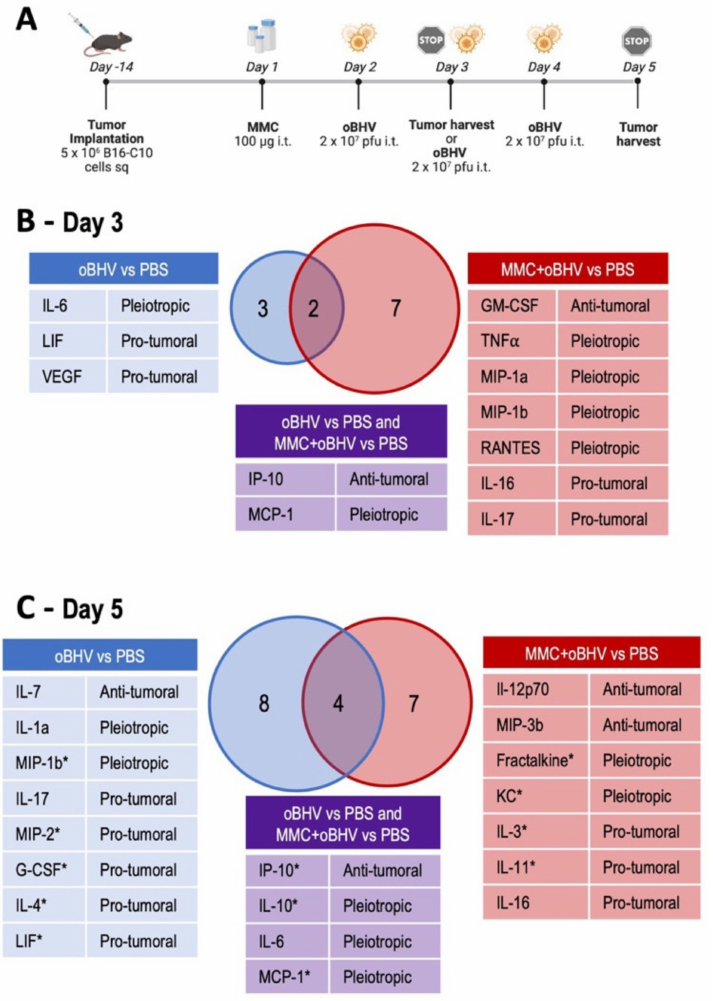
Figure 6. Cytokine analysis of tumors treated with PBS, oBHV or MMC + oBHV. On days 3 and 5, tumors were harvested and processing for cytokine quantification via Mouse Cytokine 44-Plex Discov- ery Assay ( A ). Venn diagrams represent the number of cytokines in treated tumors on day 3 ( B ) and day 5 ( C ) whose levels were significantly increased compared to PBS-treated tumors ( p < 0.05). Each upregulated cytokine is shown with its reported function in cancer [47–55]. * indicates the cytokines that were reported to regulate production, activation or recruitment of myeloid cells [56–64]. MIP-1a = CCL3, MIP-1b = CCL4, RANTES = CCL5, IP-10 = CXCL10, MCP-1 = CCL2, Fractalkine = CX3CL1, MIP-2 = CXCL-2, MIP-3b = CCL19, KC =